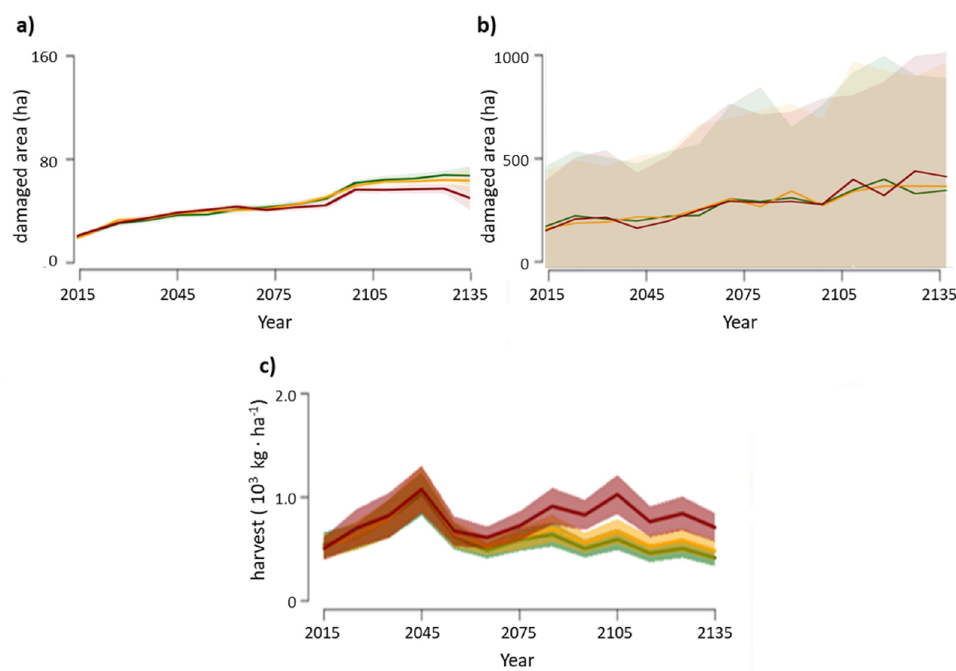
Figure 4. Variation in the average area damaged by ( a ) wind ( b ) and insects and ( c ) the harvested biomass across climate change scenarios. RCP 2.6 (green), RCP 4.5 (orange) and RCP 4.5 (red).